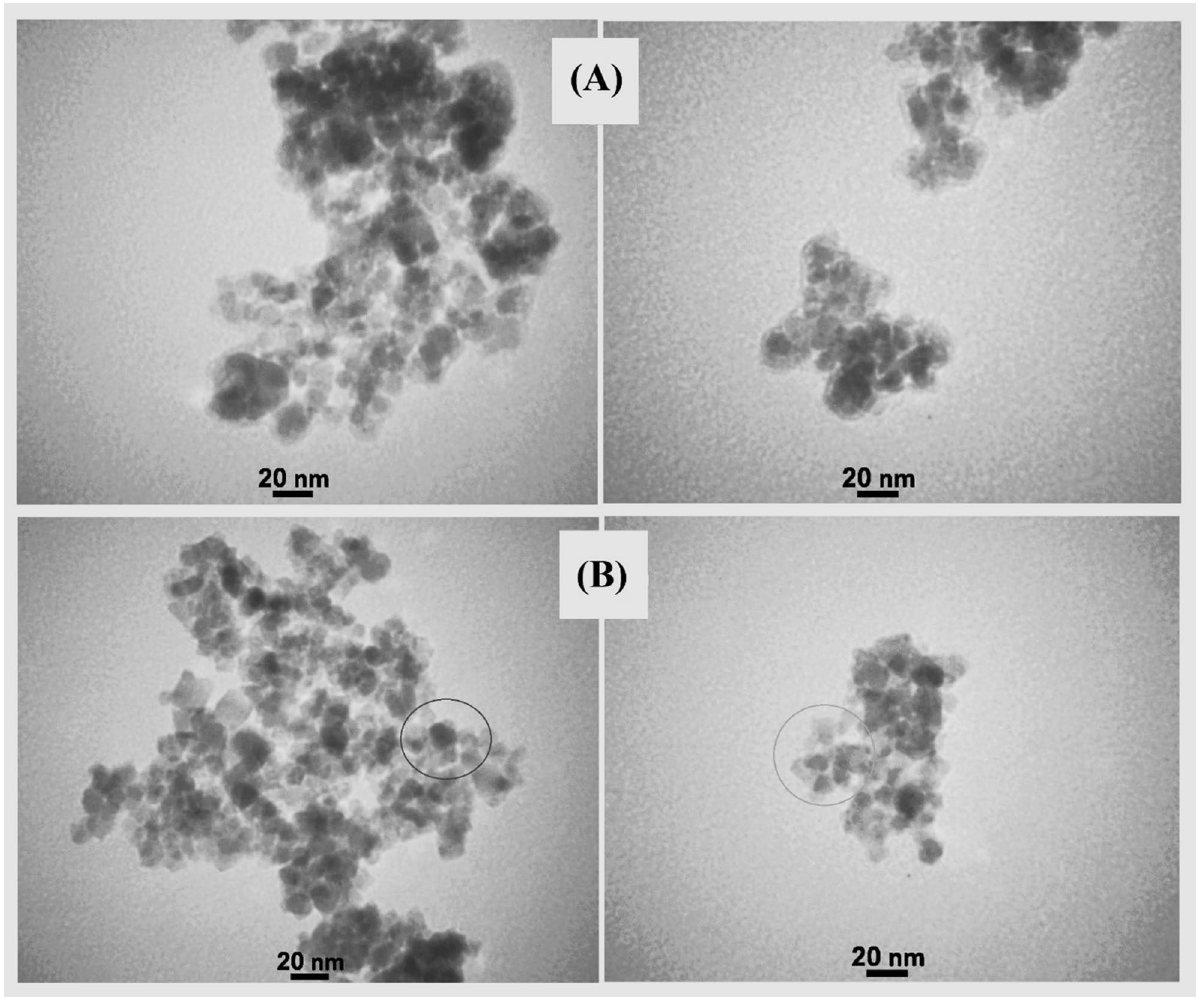
Figure 5. TEM images of ( A ) Fe 3 O 4 @CQD and ( B ) Fe 3 O 4